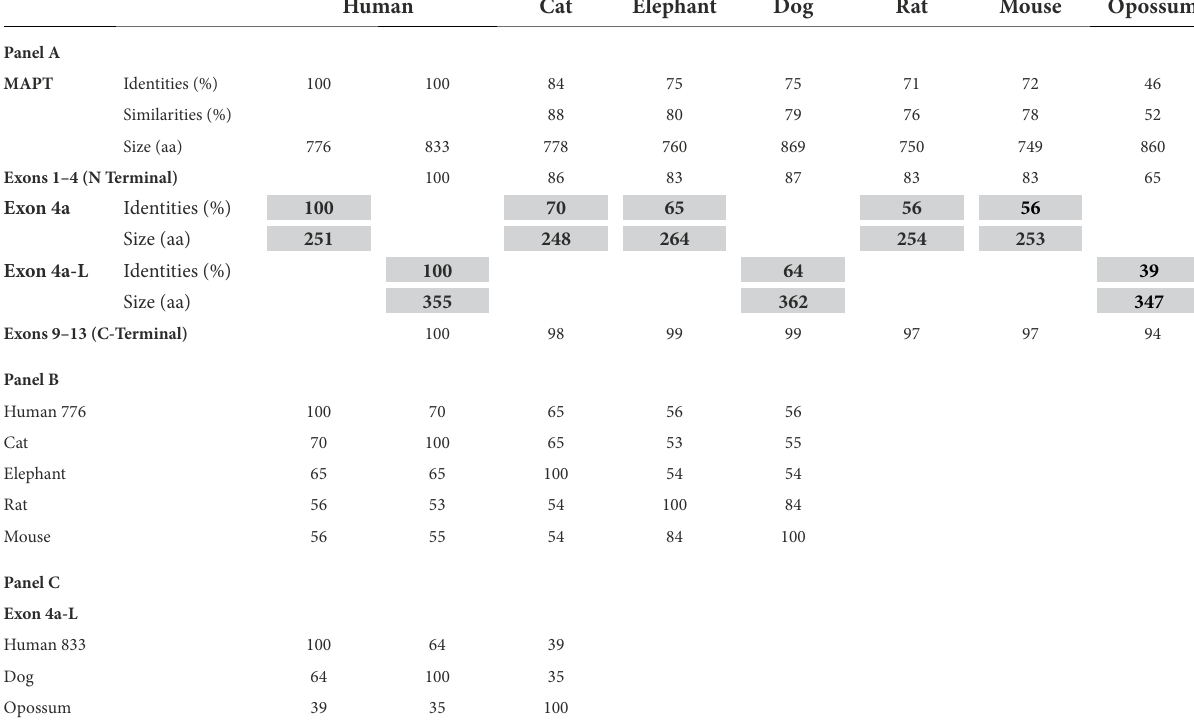
Panel A: MAPT sequence homology was analyzed against human (776aa and 833aa) for cat (778aa), elephant (760aa), dog (869aa), rat (750aa), mouse (749aa), and opossum (860aa) all taken from the database presented in Supplementary Figure 1. It included homology (identity and similarity) for the complete MAPT sequence relative to human MAPT, exons 1–4 representing the N-terminal, exon 4a, exon4a-L and exons 9–13 representing the C-terminal including the MTBD. Panel B: matrix identity for exon 4a. Panel C: matrix identity for exon